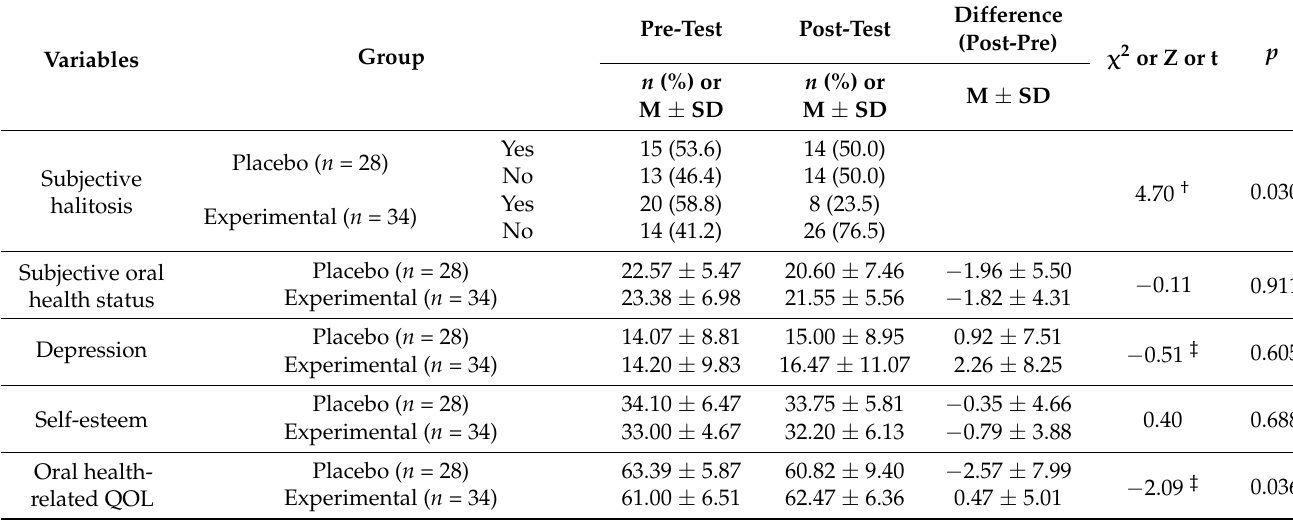
Table 2. Comparisons of dependent variables between the experimental and placebo groups after treatment ( n =